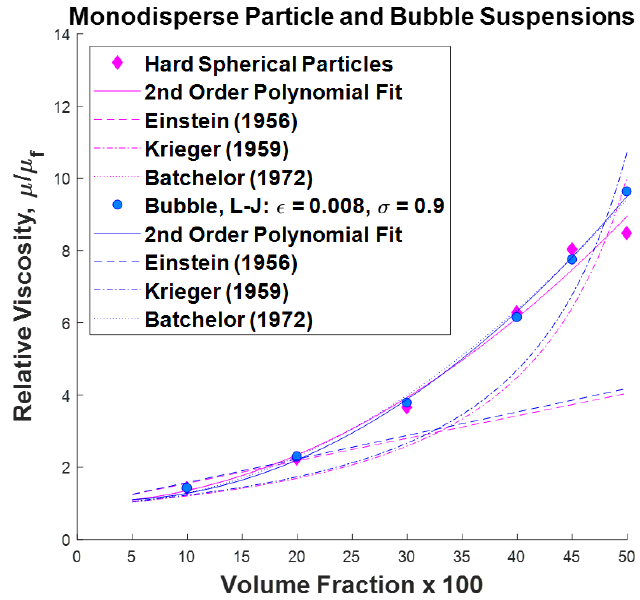
Figure 2. The relative viscosity determined from the simulated results is indicated by points and the lines are the equations fit to the data.